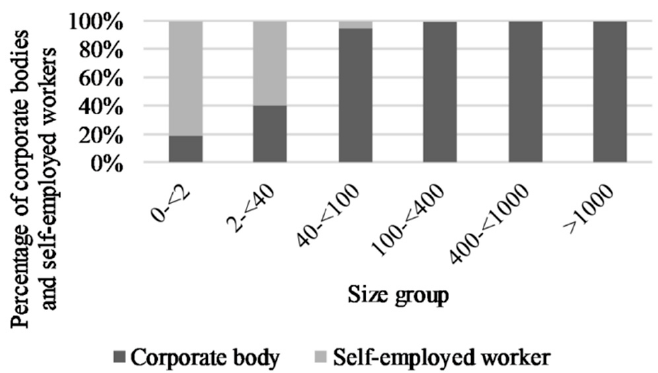
Figure 9. Percentage of corporate bodies and self-employed workers in size groups in 2016 (ARIB).